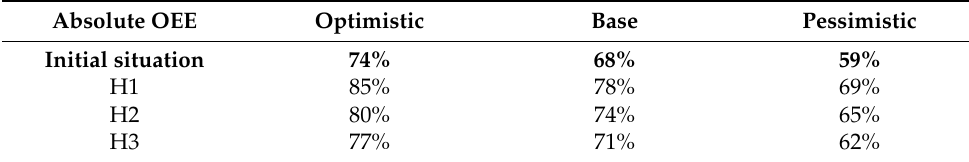
Table 4. Final OEE values obtained according from the different scenarios and hypothesis. Absolute OEE Optimistic